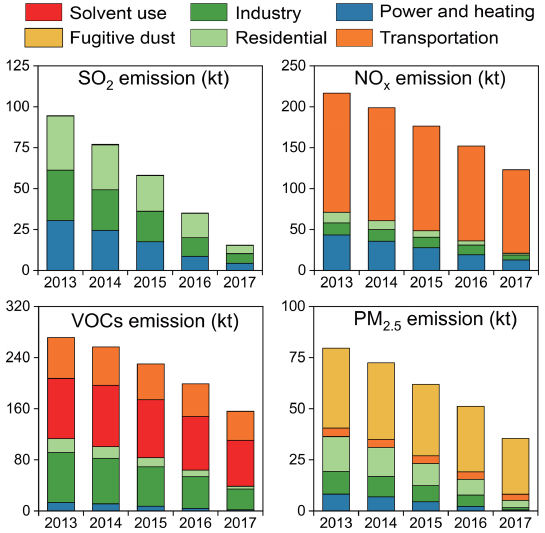
Figure 4. Changes in anthropogenic emissions of SO 2 , NO x , VOCs, and primary PM 2 . 5 in Beijing during